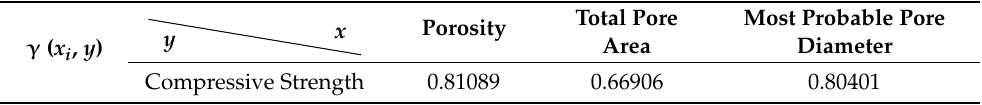
Table 6. Grey correlation coefficients between pore characteristic parameters and compressive